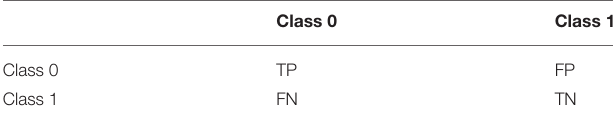
TABLE 7 | Confusion matrix for binary